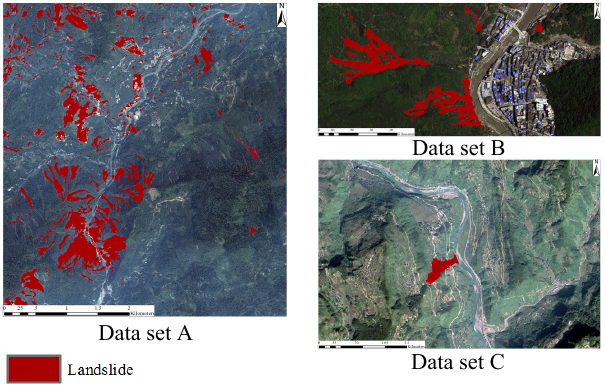
Figure 5. Results of landslide extraction